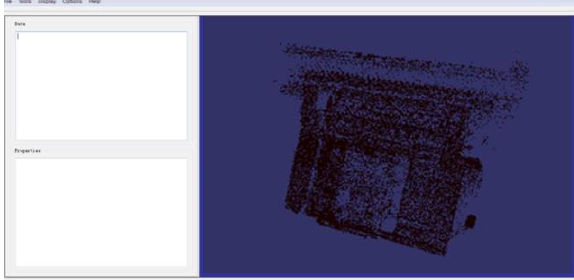
Figure 7. Point cloud data visualization of Ren Xiang gate